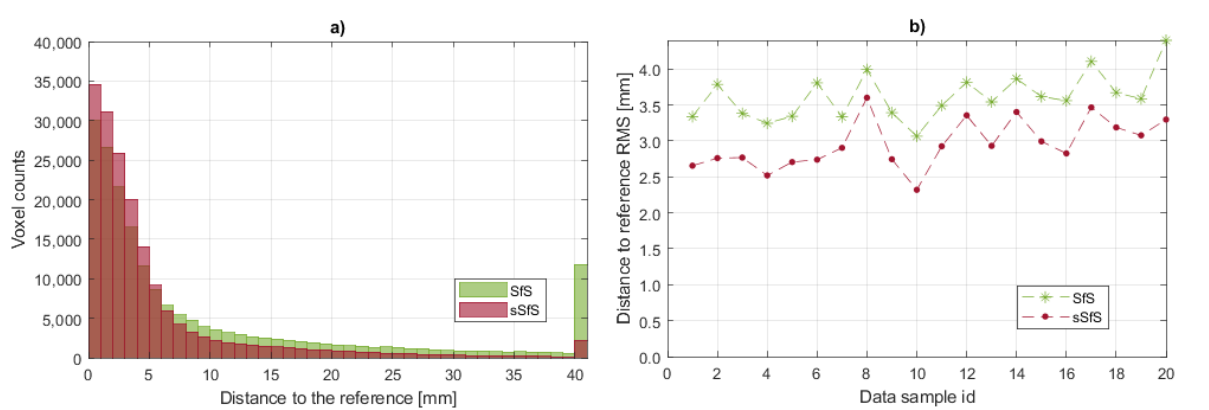
Figure 10. P2S error histograms: ( a ) overlapping SfS and sSfS histograms for dataset sample #6. The x -axis represents the histogram bin ranges with a bin of 1 mm. The last bin contains the sum of all samples with a distance >40 mm; ( b ) RMS of the P2S distances for SfS and sSfS reconstructions for the entire validation dataset.